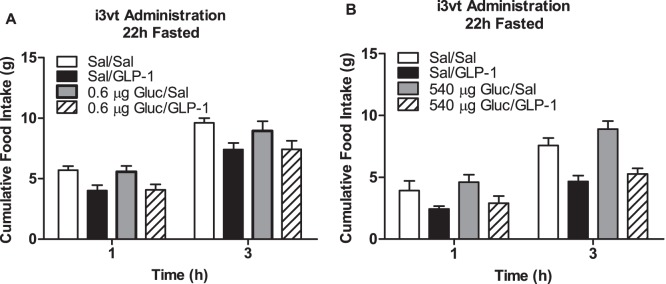
The ability of i3vt glucose to potentiate the anorexic effect of GLP-1 in fasted animals.Food intake after i3vt glucose at doses of a) 0.6 µg or b) 540 µg or saline plus GLP-1 or saline in 22 h fasted animals. With both doses of glucose, there was a main effect of drug with animals given GLP-1, regardless of glucose dose, having suppressed food intake (p<0.05; main effect of group). Open bar, i3vt saline+ i3vt saline; closed bar, i3vt saline+i3vt GLP-1; gray bar, i3vt glucose+ i3vt saline; hatched bar, i3vt glucose+i3vt GLP-1.